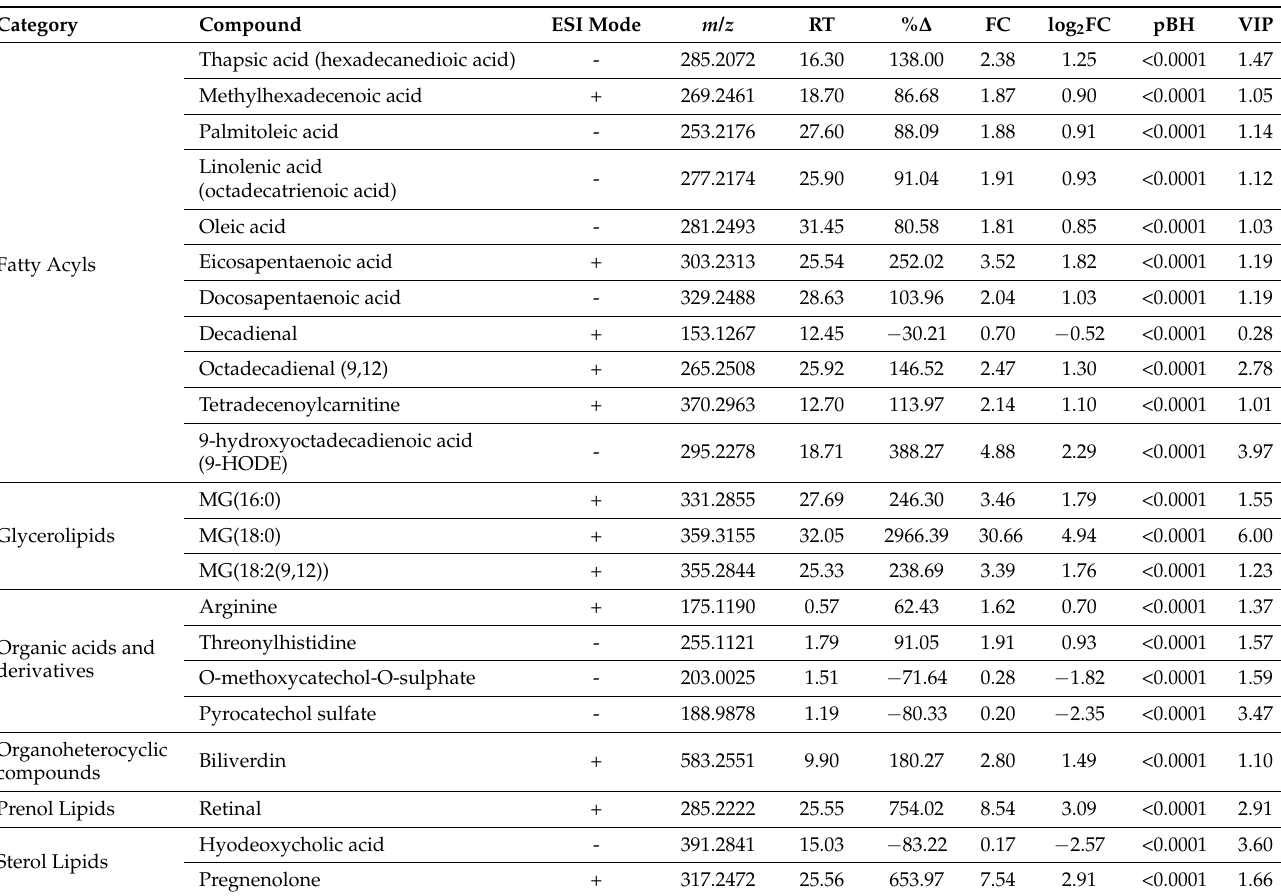
Table 2. Significantly altered metabolites, detected by LC-MS, between patients with prostate cancer and healthy control